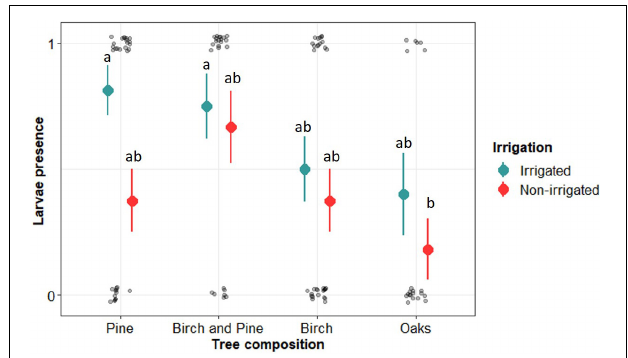
FIGURE 3 | Presence of Ixodes ricinus larva as a function of tree composition and irrigation in the plot. Graph made on raw data. Pine include Pine with or without oaks, Birch includes Birch with or without oaks, Birch and Pine include Birch with pine with or without oaks, and Oaks includes oaks only. Mean values with common letters were not significantly different (Tukey’s post hoc test). Dots and solid lines represents mean ± SE calculated on raw